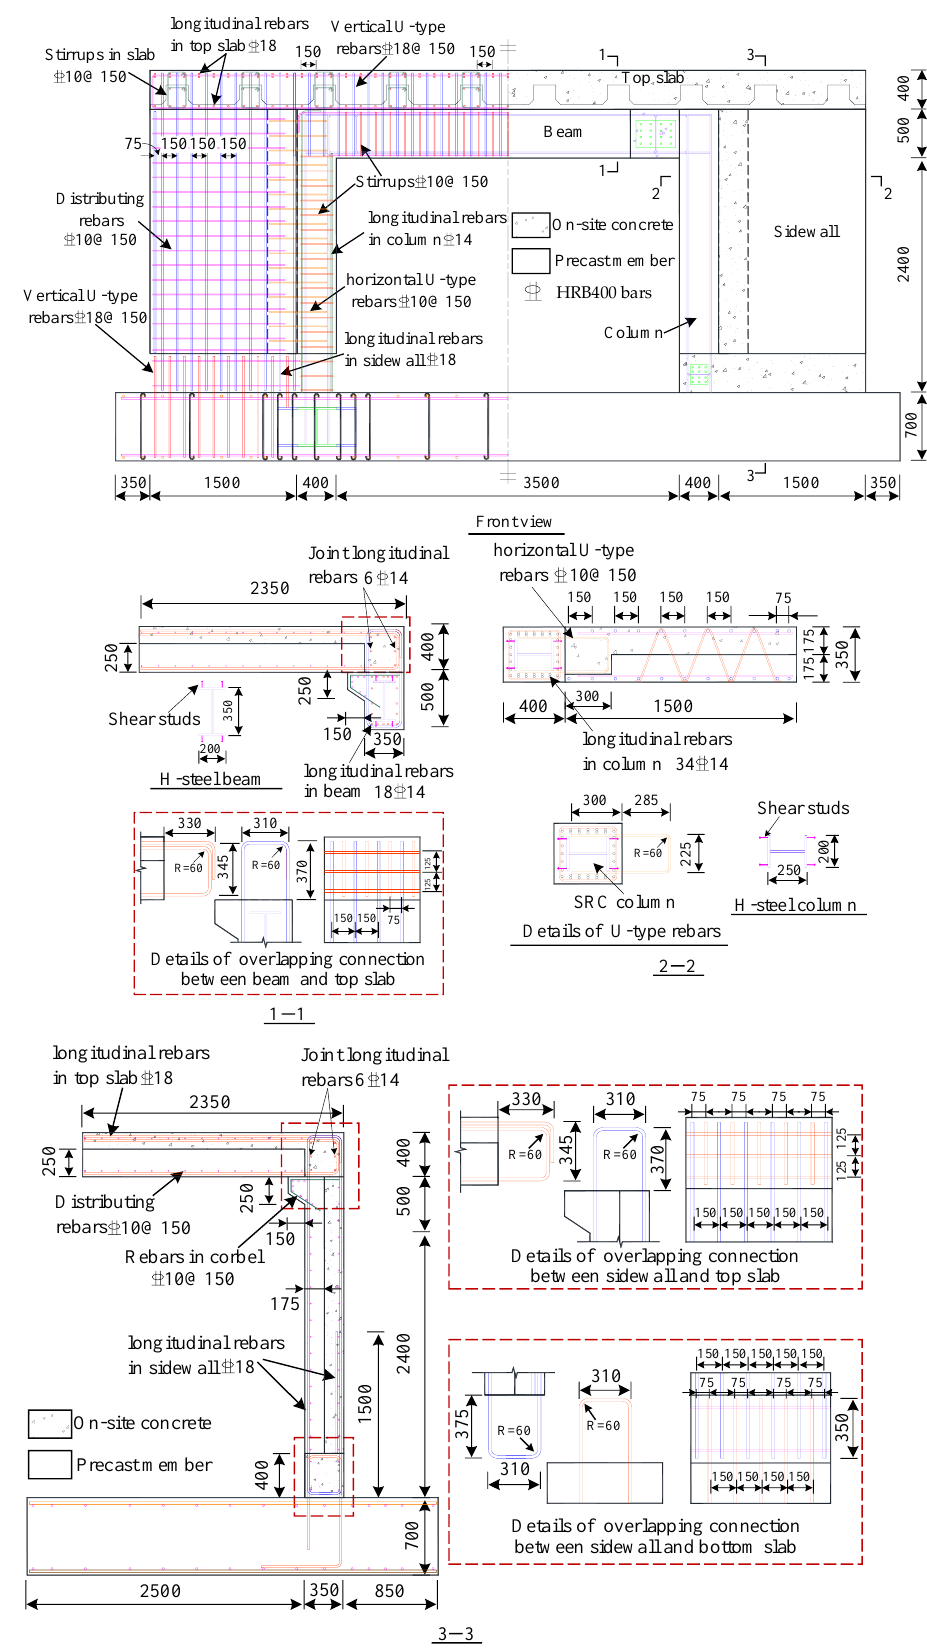
Figure 4. Dimensions and reinforcement details of the test specimen (units: mm). Table 1. Parameters of the test specimen.